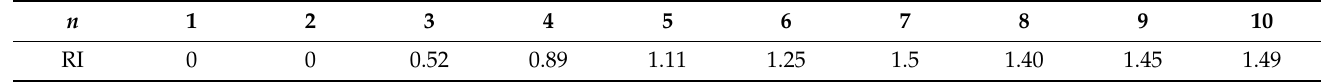
Table 3. The Random Index